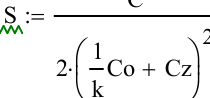
Figure 3. Quartz crystal pulling and linearization for k = 1, 2, 3 in the range C